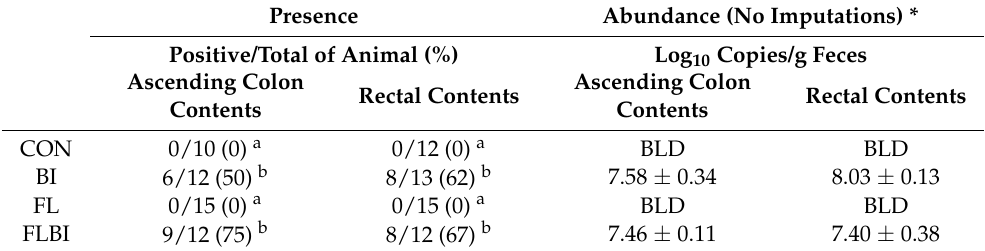
Table 4. Presence and Absolute Abundance of Gene Copies of B. infantis in Ascending Colon and Recal